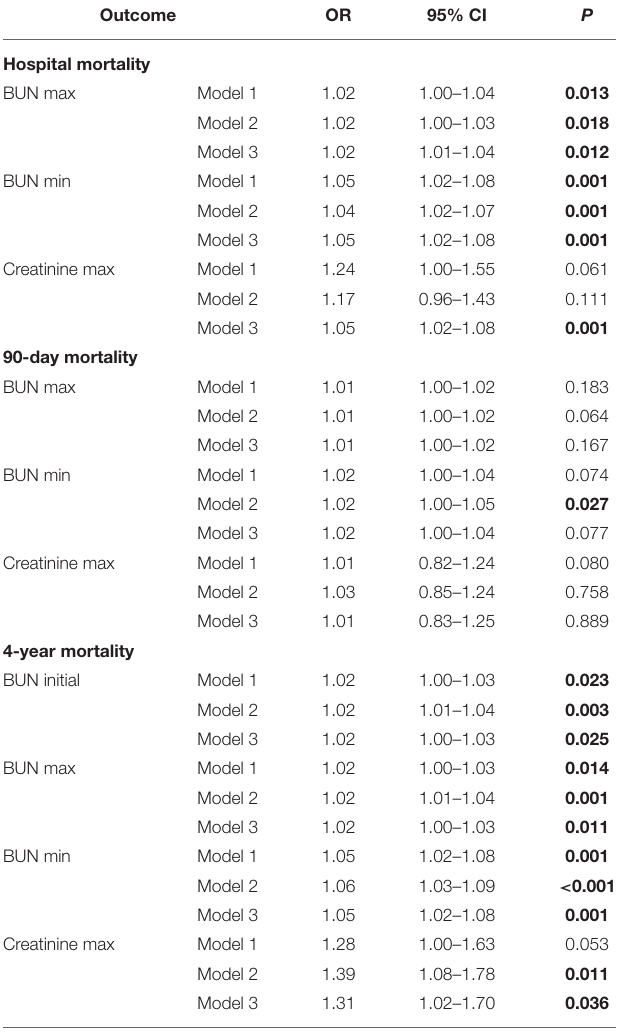
TABLE 7 | Association between BUN and creatinine with prognosis of PPH patients. Outcome OR 95% CI P Hospital mortality